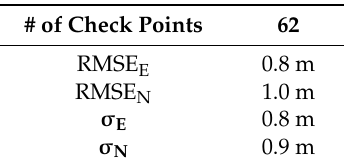
Table 6. Geometric accuracy of class “building” (E = easting, N = northing).